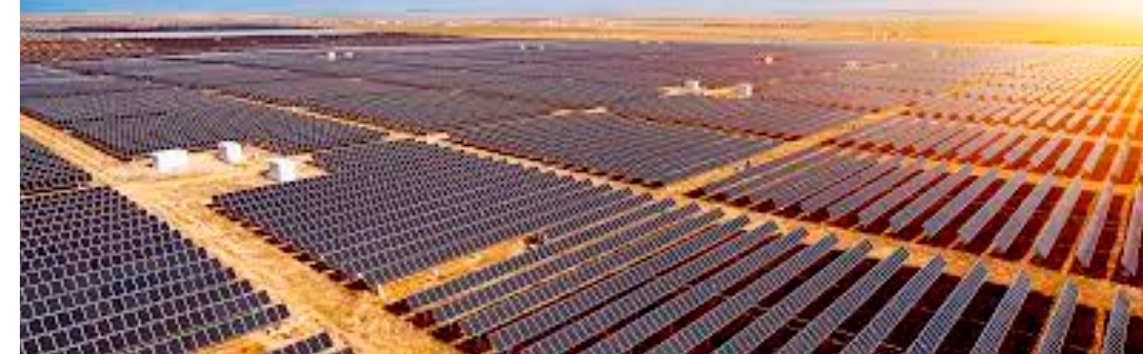
Figure 11. The Australia–Asia Power Link [22].